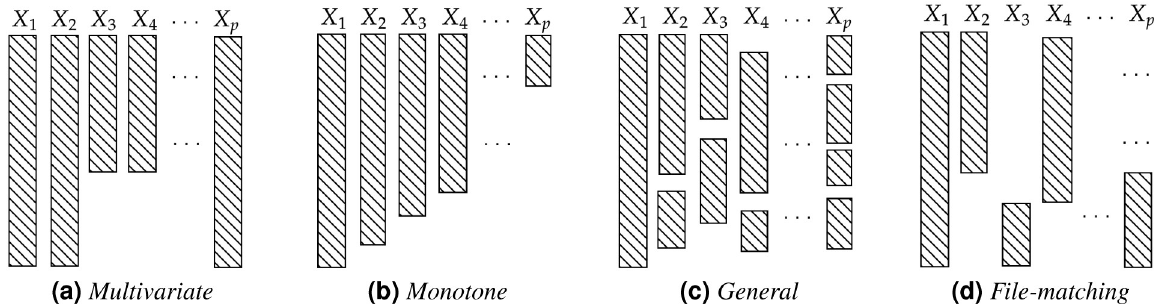
Fig 1. Types of missing data patterns. ( a ) Multivariate . ( b ) Monotone . ( C ) General . ( d ) File-matching .